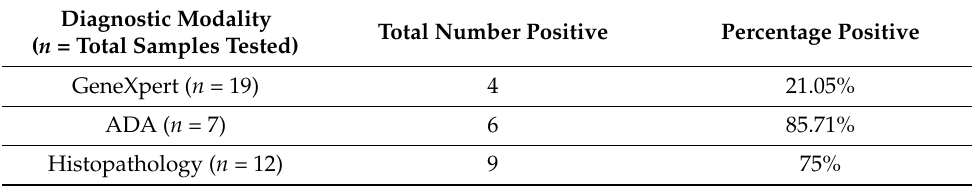
Table 3. Percentage of extra-pulmonary Tuberculosis diagnosed by different modalities.